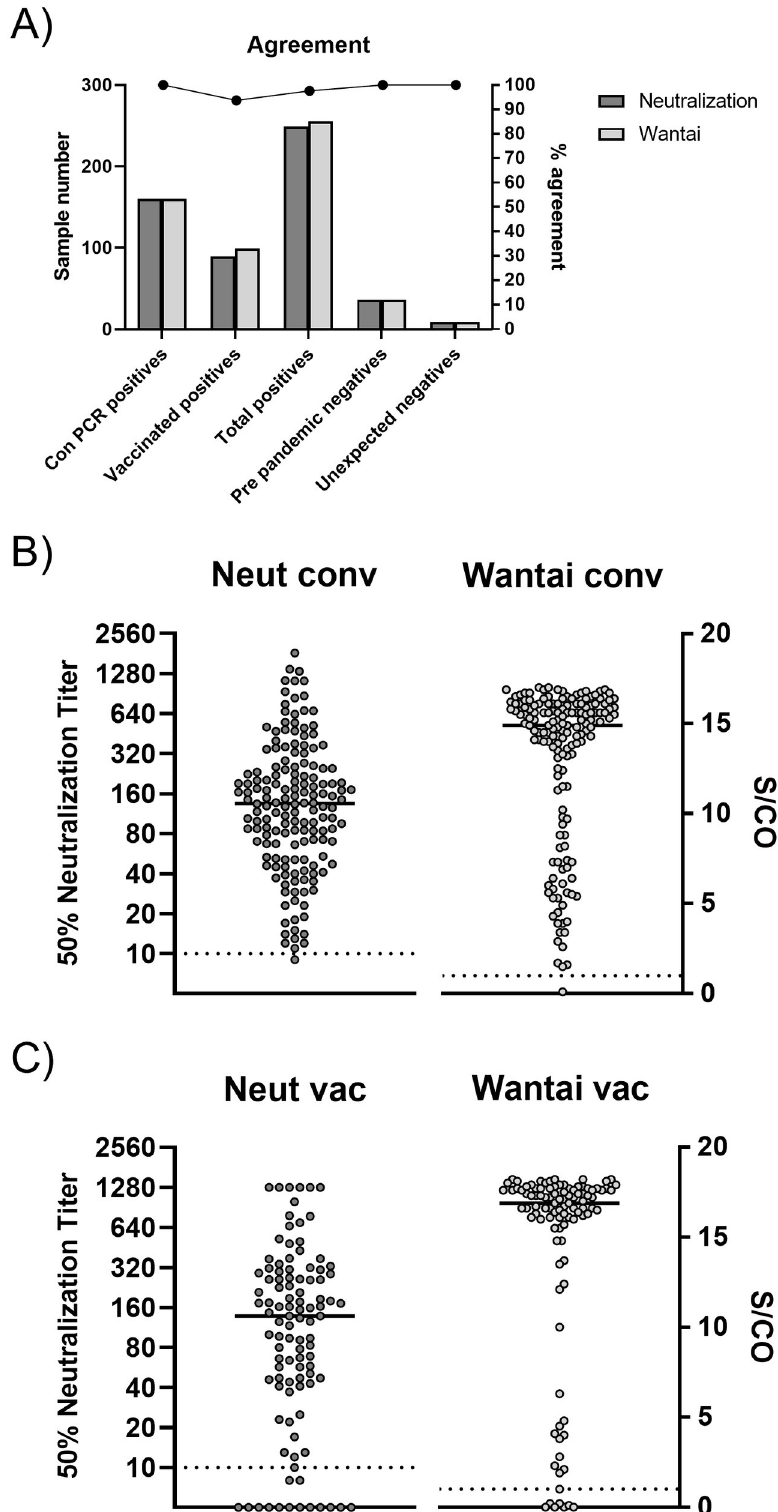
Fig 7. Agreement and data distribution of neutralizing antibody and total antibody results. Qualitative result comparison between SARS-CoV-2 virus neutralization qualitative results and Wantai Total Antibody ELISA kit results